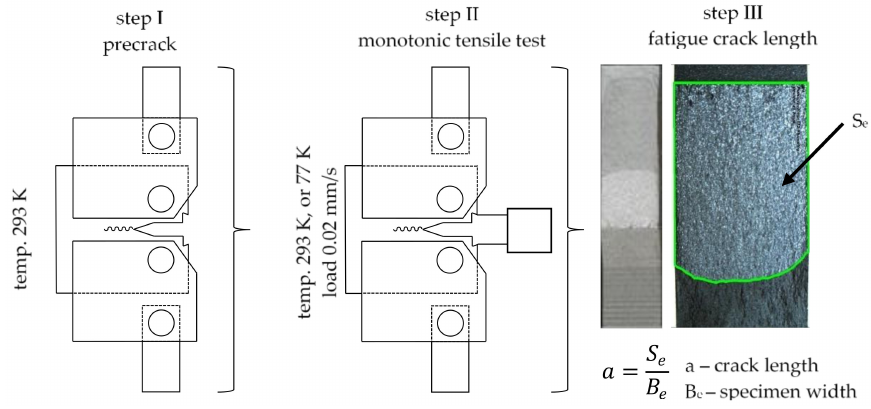
Figure 6. Graphic presentation of the testing procedure.